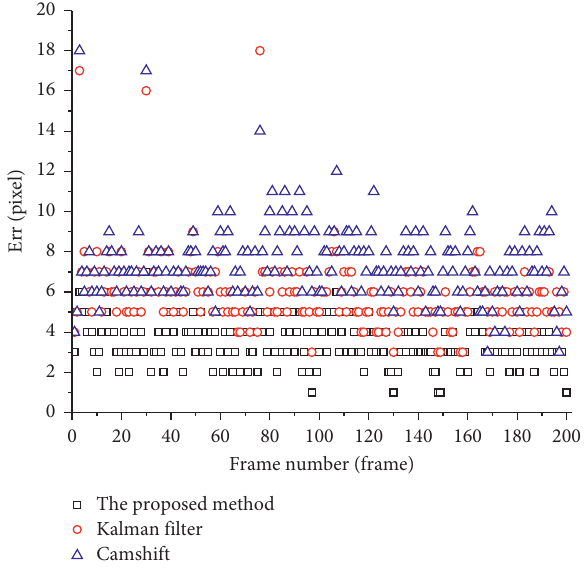
Figure 13: Comparison of centroid error for three algorithms in complex traffic scenarios.